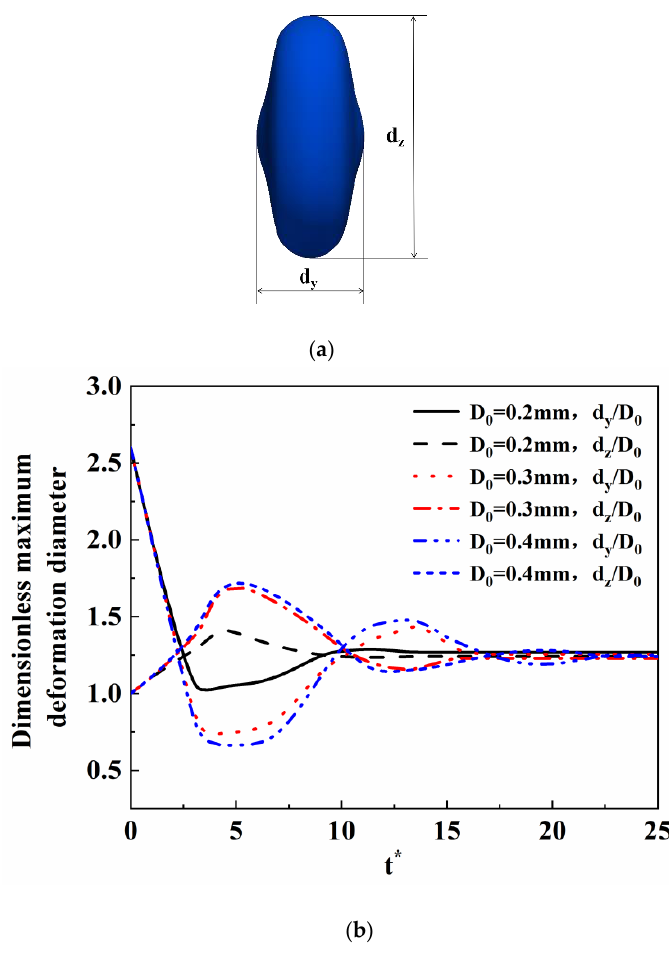
Figure 8. ( a ) The droplet deformation parameters; ( b ) the dimensionless time evolution of the dimensionless maximum deformation diameter of droplets with di ff erent initial droplet diameters.